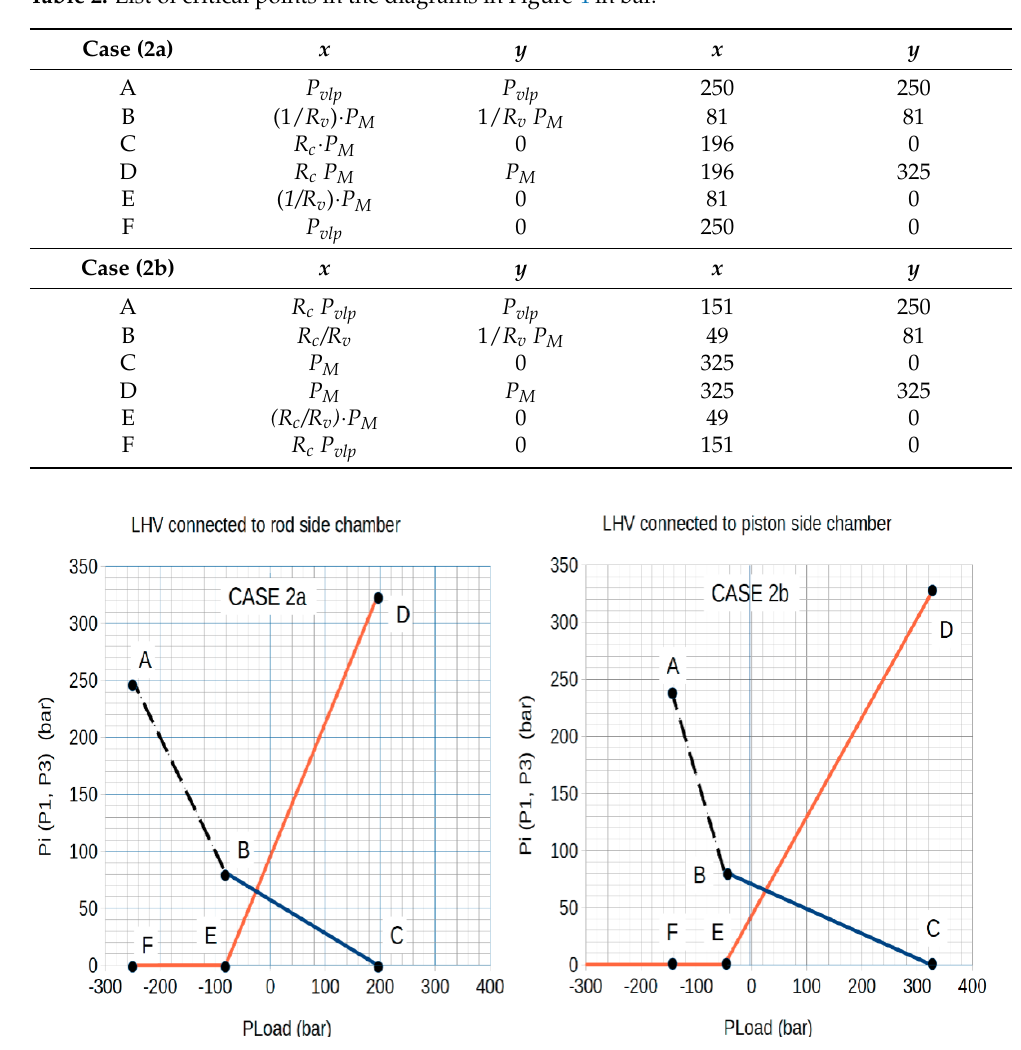
Figure 4. Steady-state operating curves 𝑃 𝑖 (𝑃 1 ,𝑃 3 ) = 𝑓(𝑃 𝑙𝑜𝑎𝑑 ) for the two cases (2a) and (2b). The meanings of points A – F are defined in Table 2.